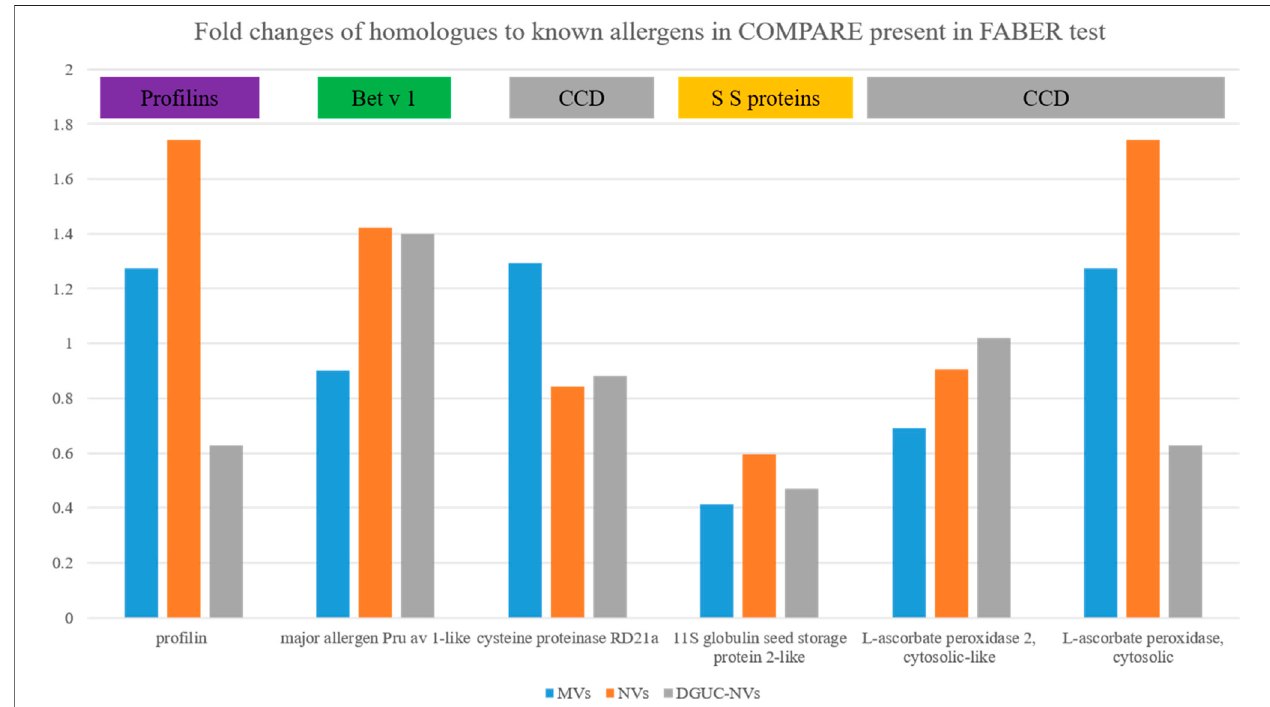
FIGURE 6 | The fold changes measured by quantitative proteomics of the six proteins, homologs to allergens commonly identi fi ed in MVs, NVs, and DGUC-NVs ( Supplementary Table S5 ).